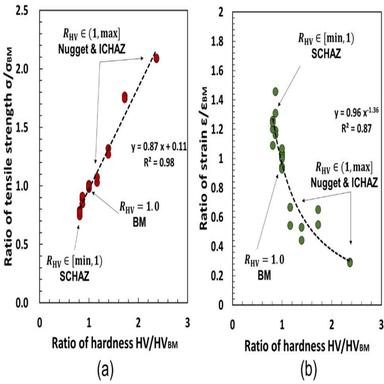
Correlations and approximations of (a) ratio of Vickers hardness and ratio of tensile strength, (b) ratio of Vickers hardness and ratio of nominal strain at tensile strength.